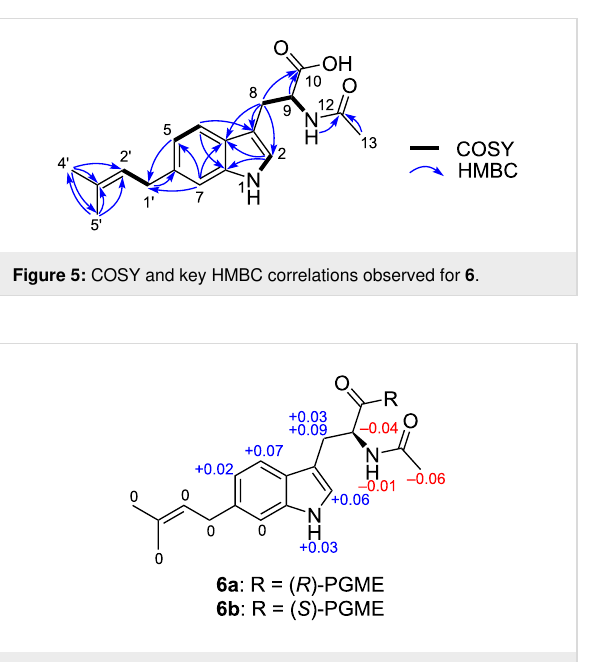
1 – 5 were marginally active against Kocuria rhizophila (MIC = 100 μ